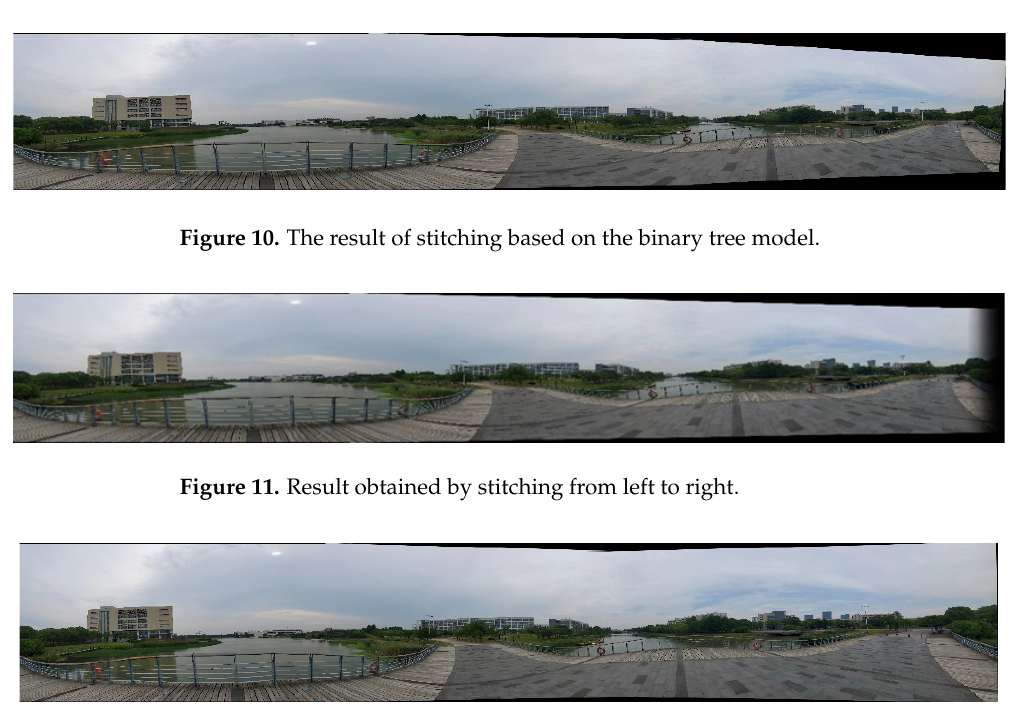
Figure 12. Result obtained with the MSIS method.